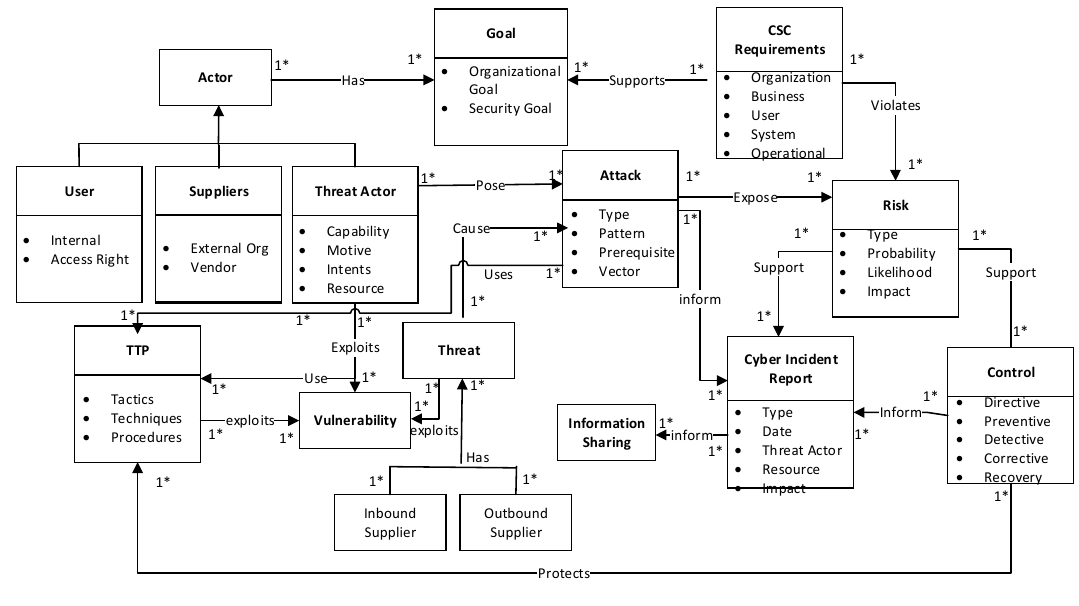
Figure 1. The Figure 1. The meta-model.